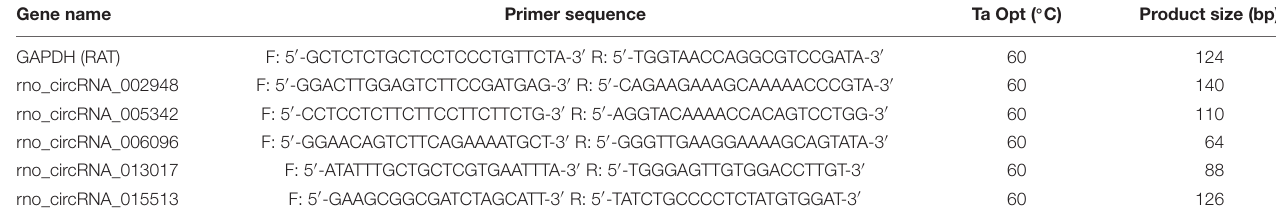
TABLE 4 | Sequences of primers used for qRT-PCR assay.